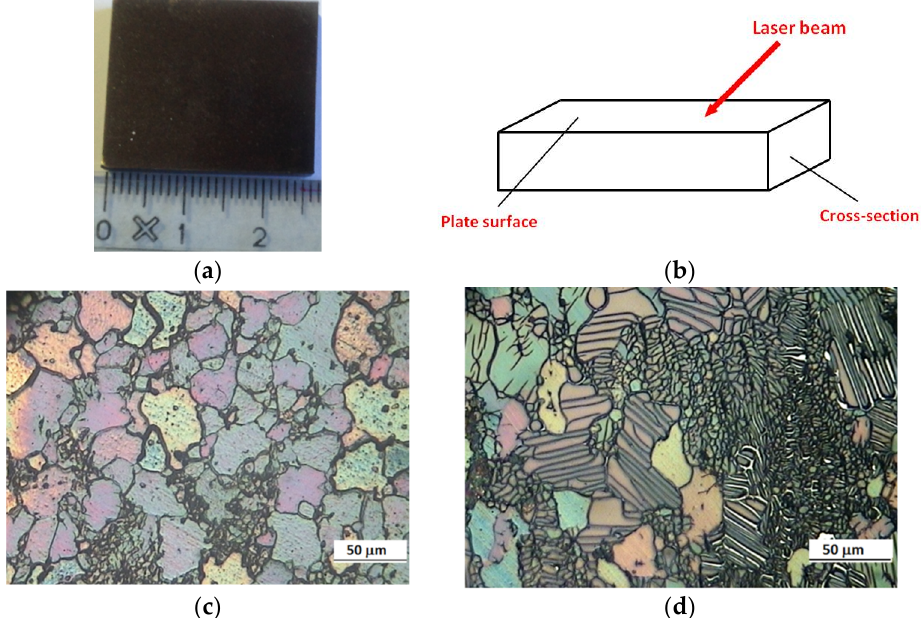
Figure 1. Picture( a ) and ( b ) sketch of the sample. The structure of the examined Mo samples: plate surface ( c ), cross-section ( d ).